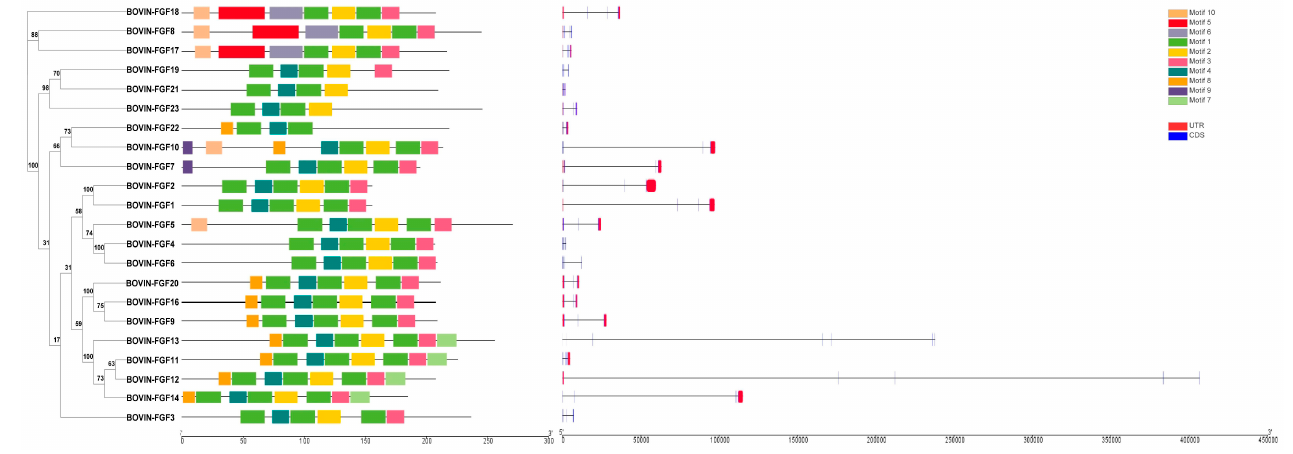
Figure 1. Phylogenetic analysis ( left ), motif analysis ( middle ), and gene structure analysis ( right ) of bovine FGF protein.